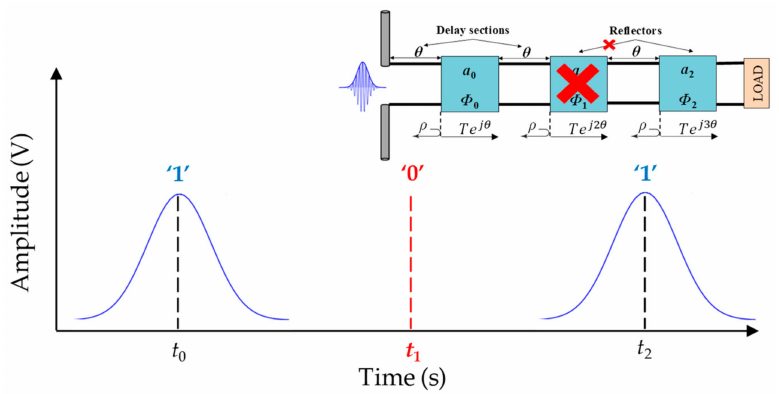
Figure 2. Working principle of on-o ff keying encoding.